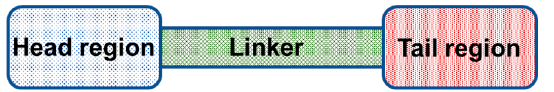
Figure 9. Graphical representation of CAIs pharmacophore.